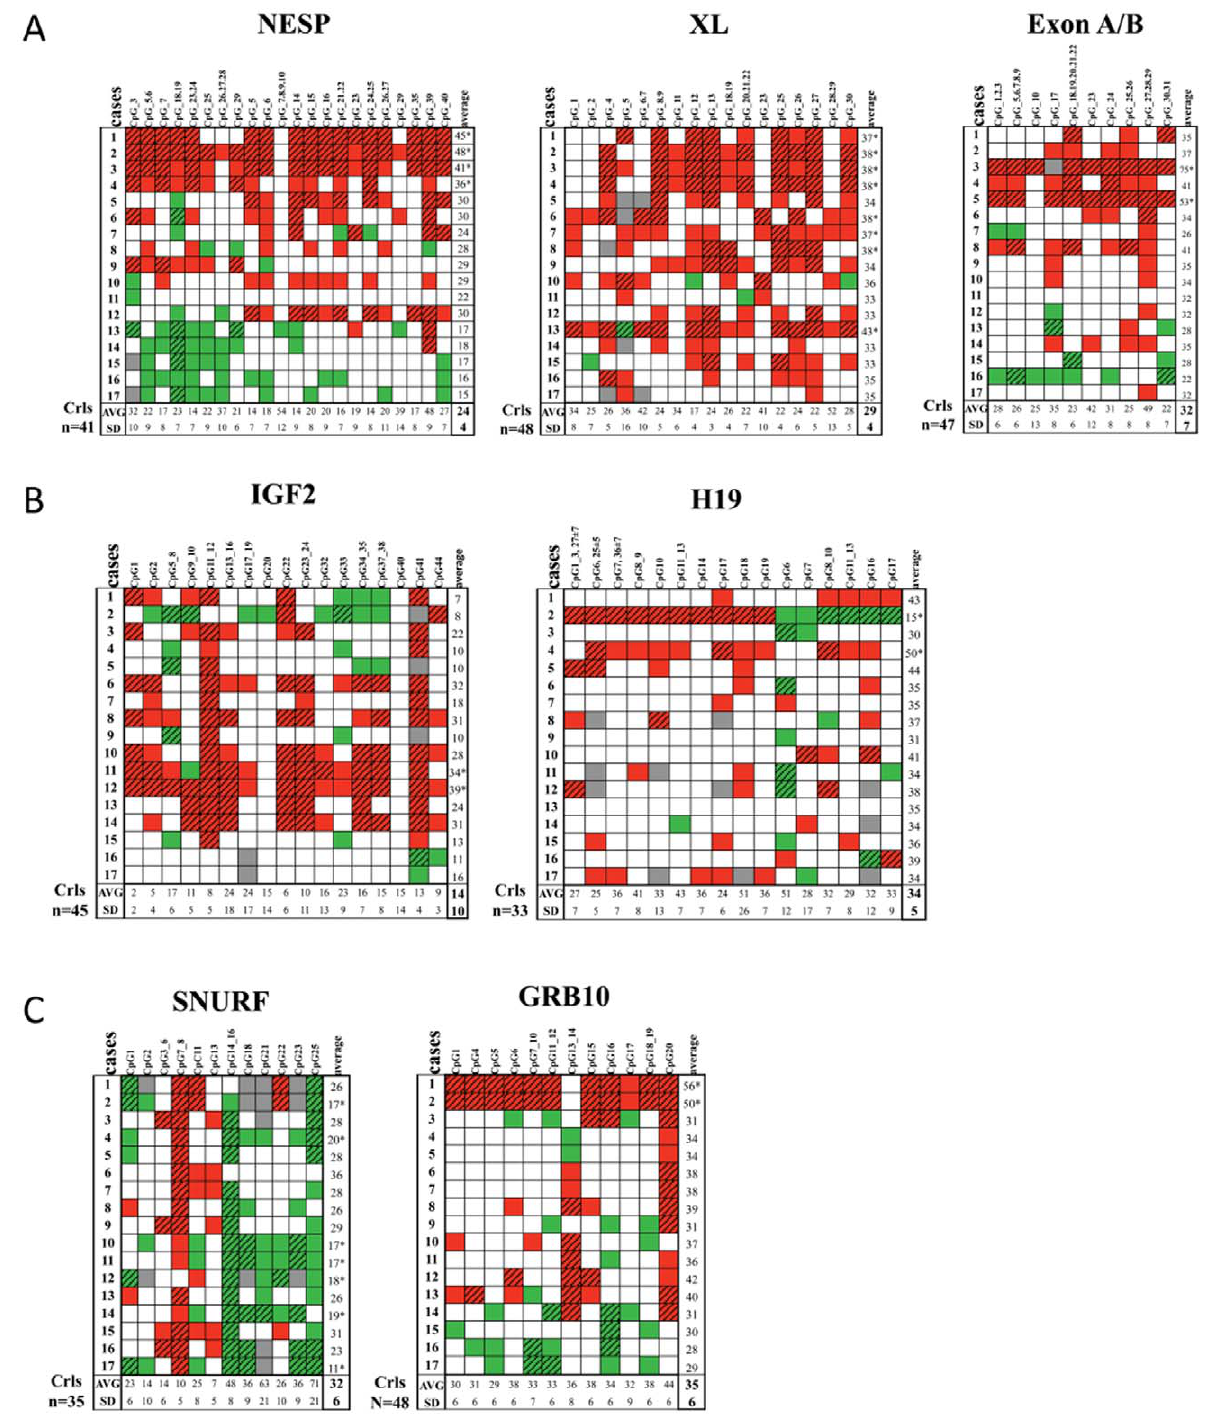
Figure 2. GNAS , IGF2 , H19 , SNURF and GRB10 methylation at single CpG sites for AHO-like patients. Single CpG site methylation values rapresentations for all patients studied via Sequenom EpiTYPER mass-array for NESP, XL, exon A/B (A), IGF2 , H19 (B), SNURF and GRB10 (C) amplicons. % of methylation are reported as mean of three replicates from at least two separate plates and two independent DNA bisulphite treatment. White include the normal methylation values that are within the mean + / 2 SD value of the indicated number of normal controls. Values that are significantly hyper- or hypomethylated are depicted as red or green diagonal striped rectangles, respectively (Z-test, p , 0.05). Red or green rectangles indicate methylation values that are outside the SD values but are not yet significant, indicative for a trend towards hyper or hypomethylation, respectively. Grey rectangles are CpG values that failed in the analysis. The mean (AVG) and Standard Deviation (SD) for each CpG in the controls are shown in the last rows. The last column in white shows the overall degree of methylation for the complete amplicon for each patient and the mean and SD for the controls. * Z-test, p , 0.05.